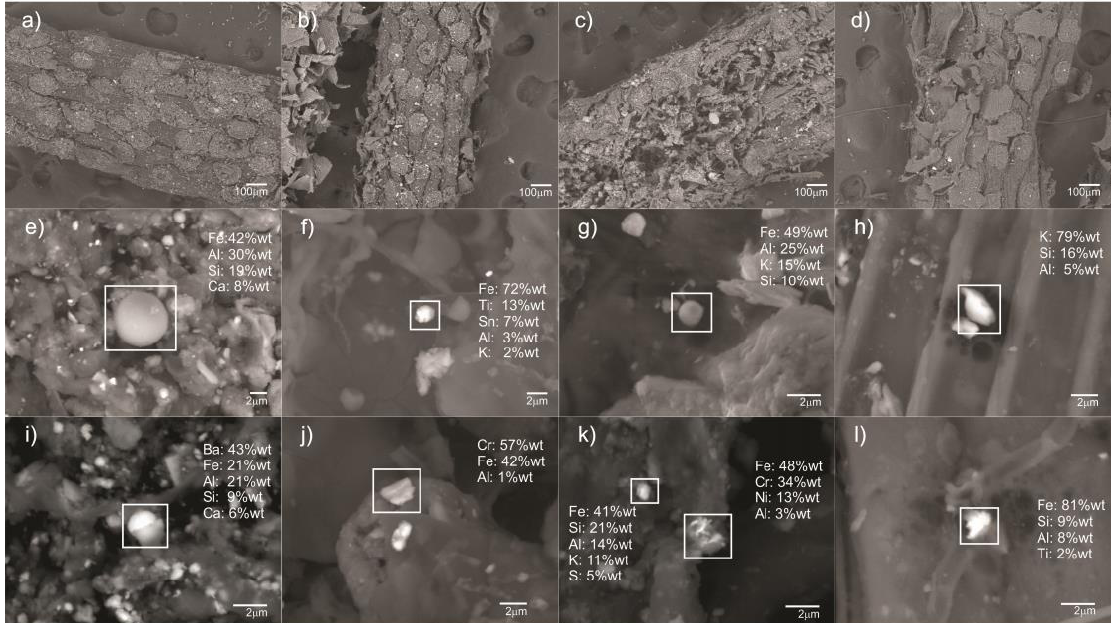
Figure 3. SEM observations on T. recurvata samples with different pollution influence from industrial ( a ), vehicular ( b ), and residential ( c ) areas, as well as the control site ( d ). Composition by EDS of Fe-rich particles observed in samples from the industrial area (TM14, e , i ), vehicular area (TM02, f , j ), residential area (TM131, g , k ), and control area (BASE 2, h , l ) are indicated with particle metal composition. A morphology and compositional analysis was performed on 49 Fe-rich particles on T. recurvata L.